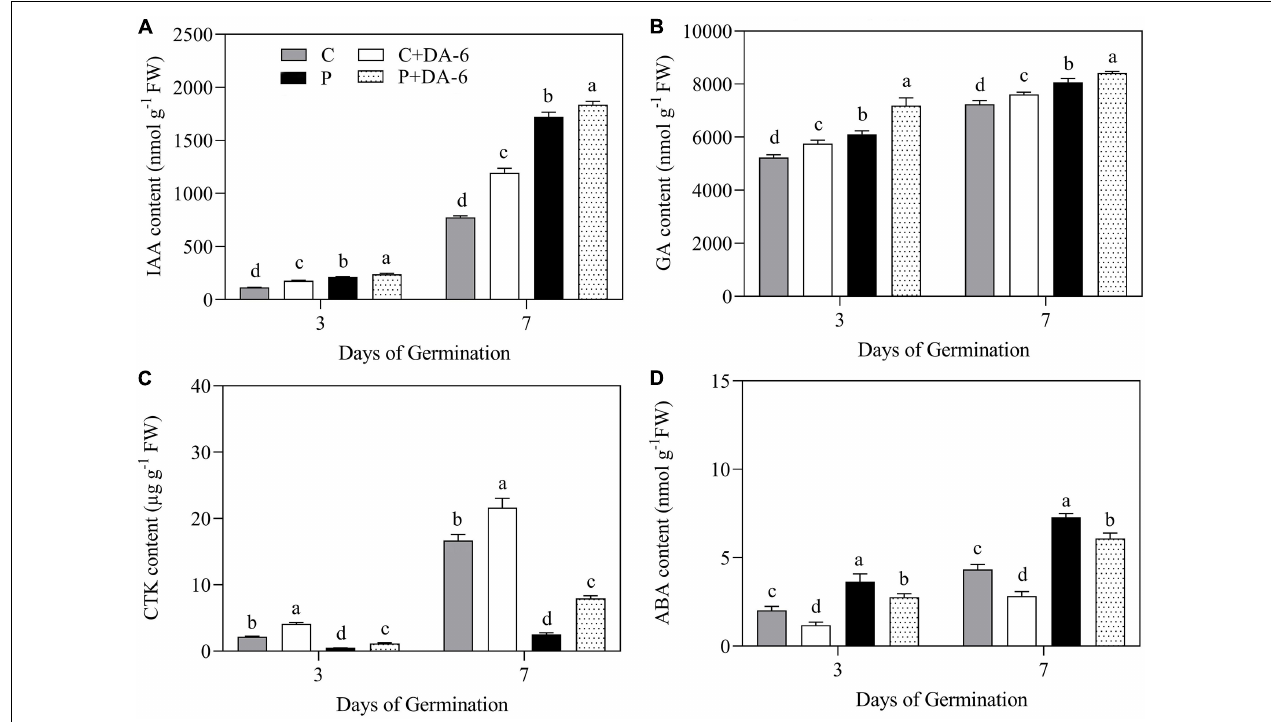
FIGURE 3 | Effects of seeds priming with water or DA-6 (2 mM) on (A) indole-3-acetic acid (IAA) content, (B) gibberellin (GA) content, (C) cytokinin (CTK) content, and (D) Abscisic acid (ABA) content after 3 and 7 day of germination in white clover under well-watered condition and drought stress. Different letters above different treatments represent significant differences at a specific time point under well-watered condition or drought stress ( p ≤ 0.05). Vertical bars show the ± SE of mean ( n =